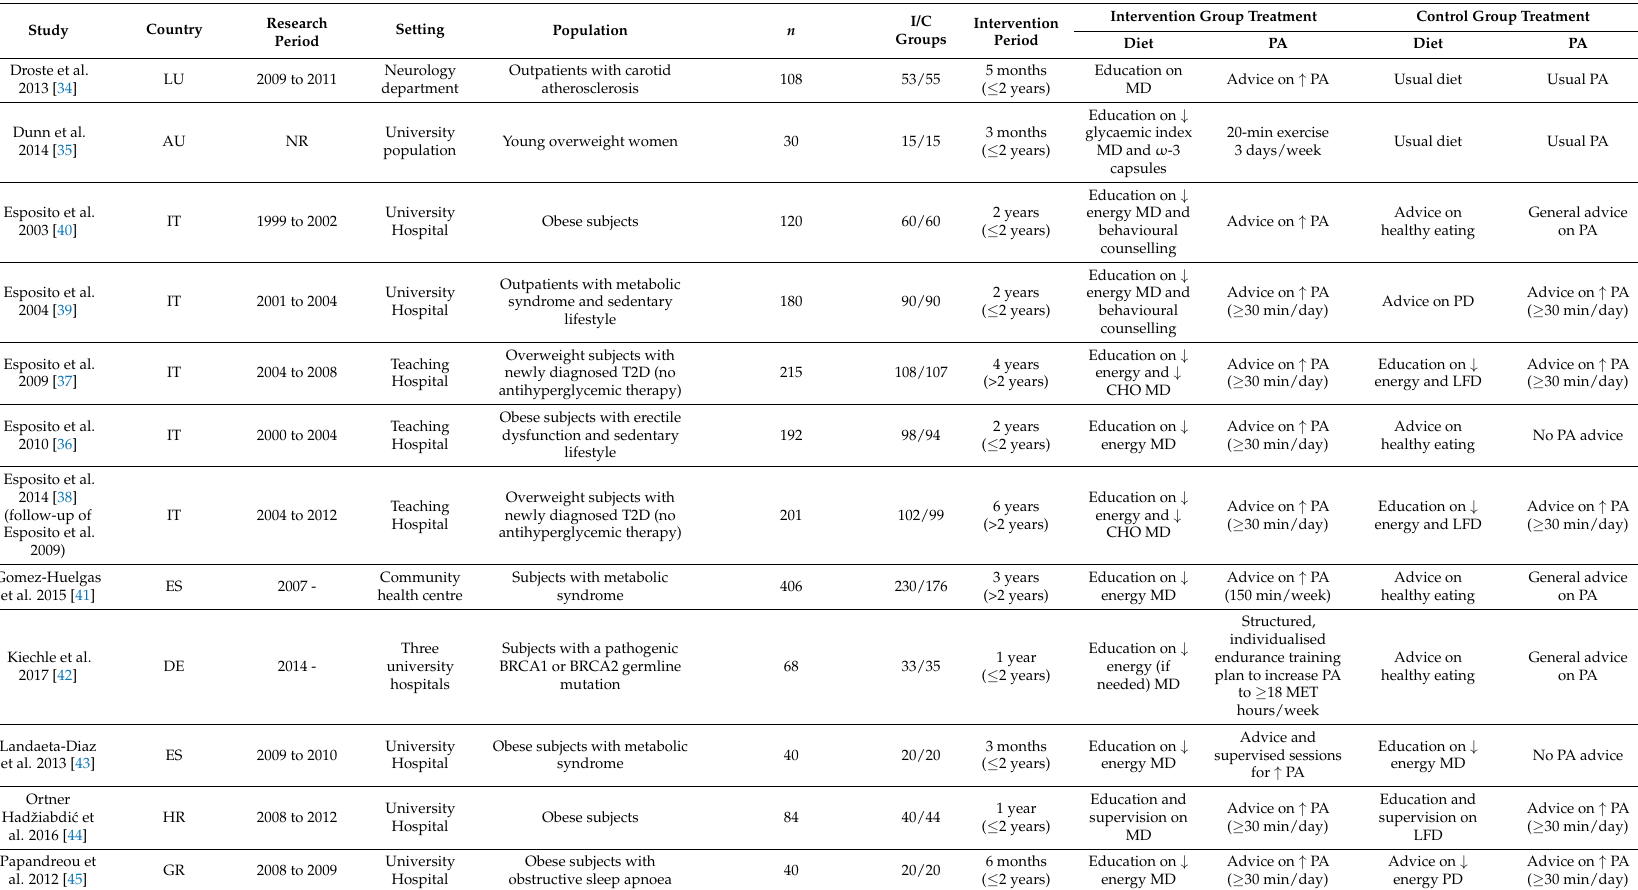
Table 1. Characteristics of included